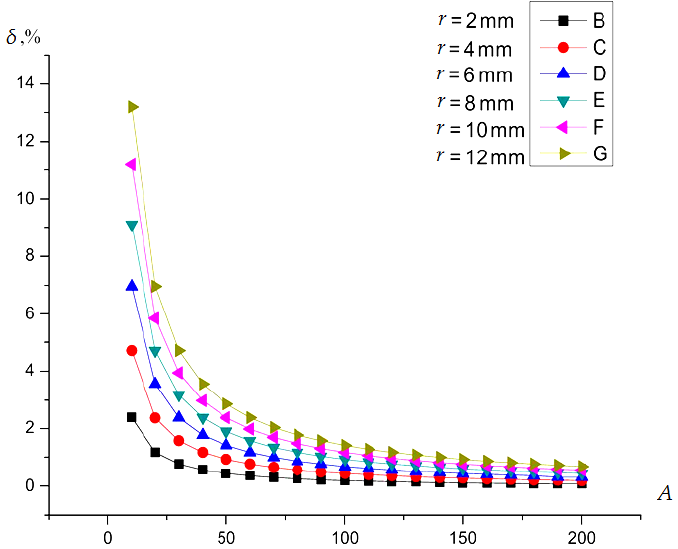
Figure 8. The error of measuring the distance to the cylindrical surface (shaft surface), depending on the ratio A = R/r .